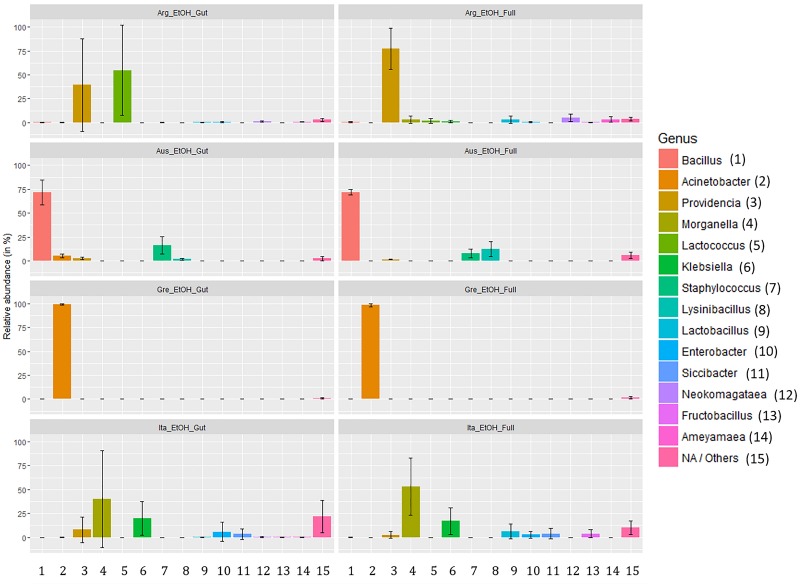
Relative abundance of gut symbionts (genus level classification) in ethanol preserved third instar larvae of C. capitata from different samples (colony – Greece, colony – Argentina, colony – Australia, wild – Italy).